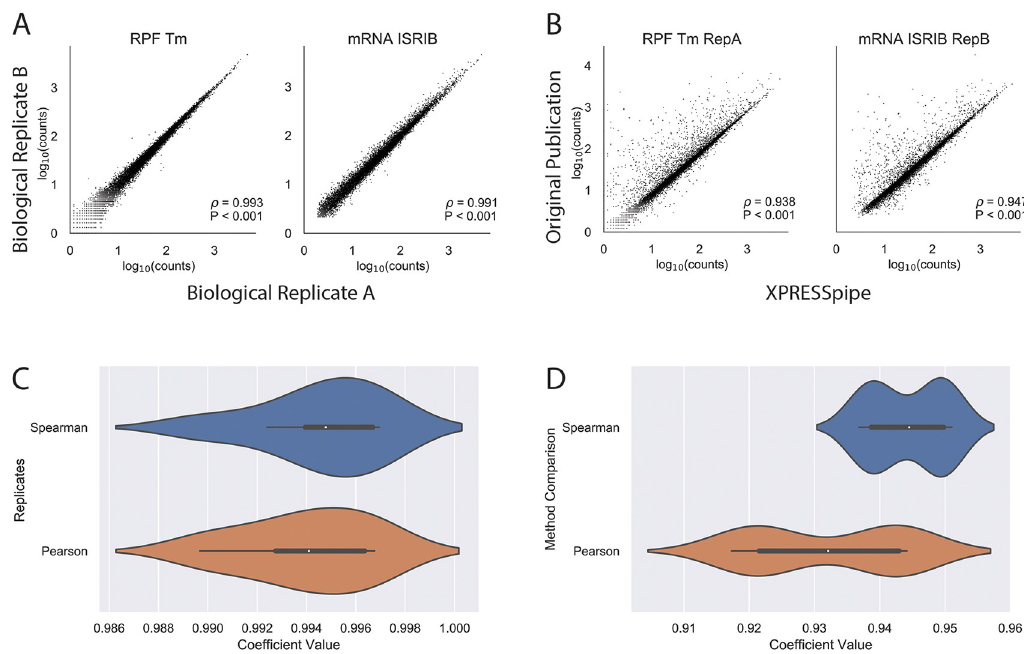
Fig 2. Representative comparisons between processed data produced by XPRESSpipe and original study. Genes were eliminated from analysis if any RNA-Seq sample for that gene had fewer than 10 counts. A) Representative comparisons of biological replicate read counts processed by XPRESSpipe. B) Representative comparisons of read counts per gene between count data from the original study and the same raw data processed and quantified by XPRESSpipe. C) Boxplot summaries of Spearman ρ and Pearson r values for biological replicate comparisons. D) Boxplot summaries of Spearman ρ and Pearson r values for between method processing. RPF, ribosome-protected fragments. Tm, tunicamycin. All ρ values reported in A and B are Spearman correlation coefficients using RPM-normalized count data. Pearson correlation coefficients were calculated using log 10 (rpm(counts) + 1) transformed data. XPRESSpipe-processed read alignments were quantified to Homo sapiens build CRCh38v98 using a protein-coding-only, truncated